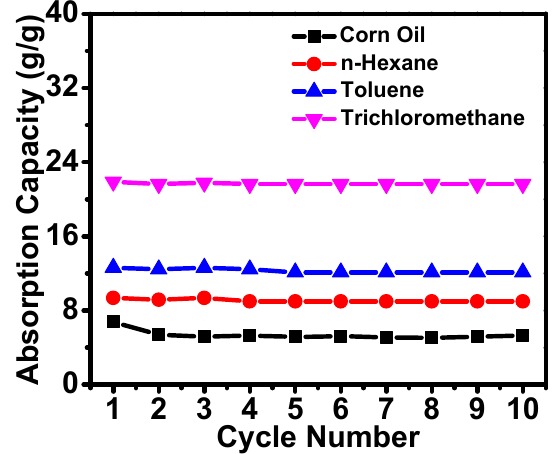
Figure 10. The cycling of the absorption capacity of the modified aerogels.